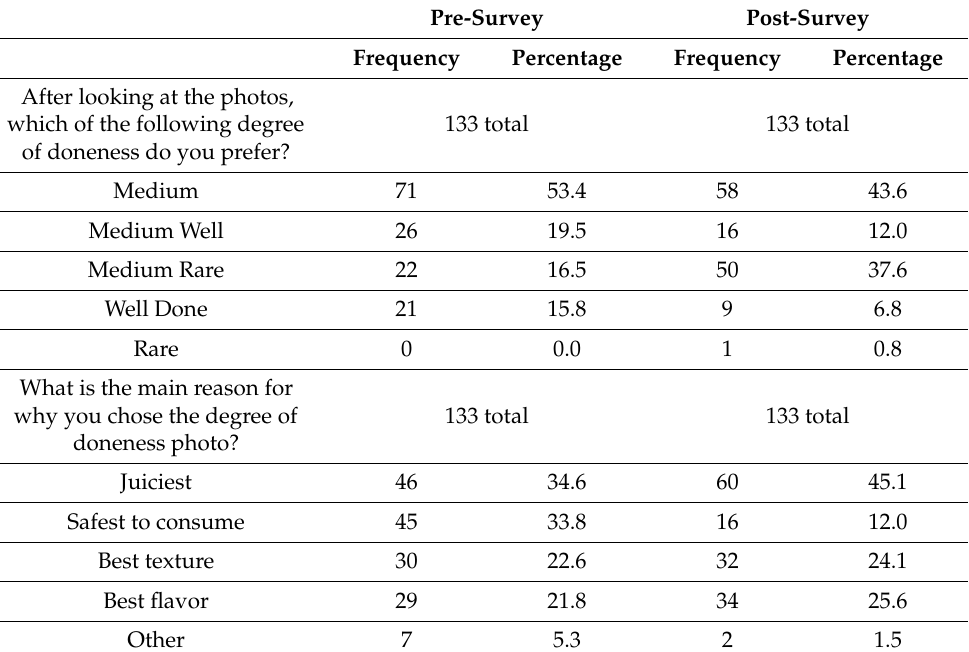
Table 6. Frequency and percentage of participants response to pre-survey and post-survey questions.